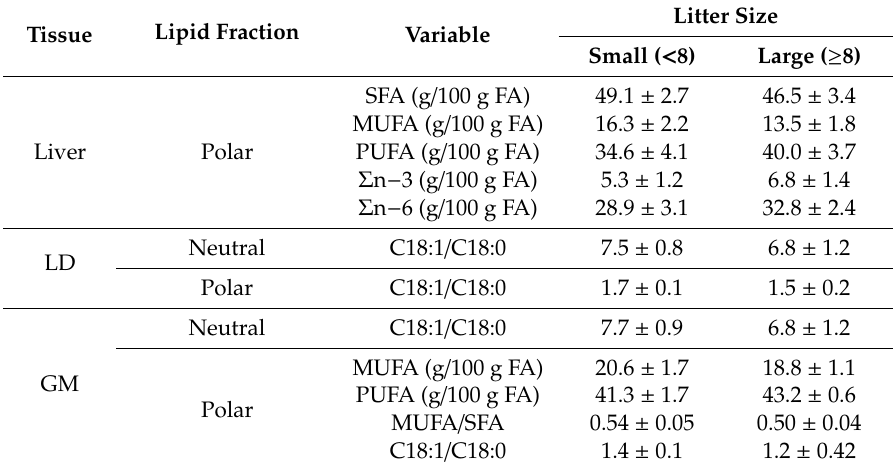
Table 3. Highlighted significant di ff erences ( p < 0.05) in fatty acid (FA) composition of di ff erent tissues between piglets from small or large litters at 25 days old. Tissue Lipid Fraction